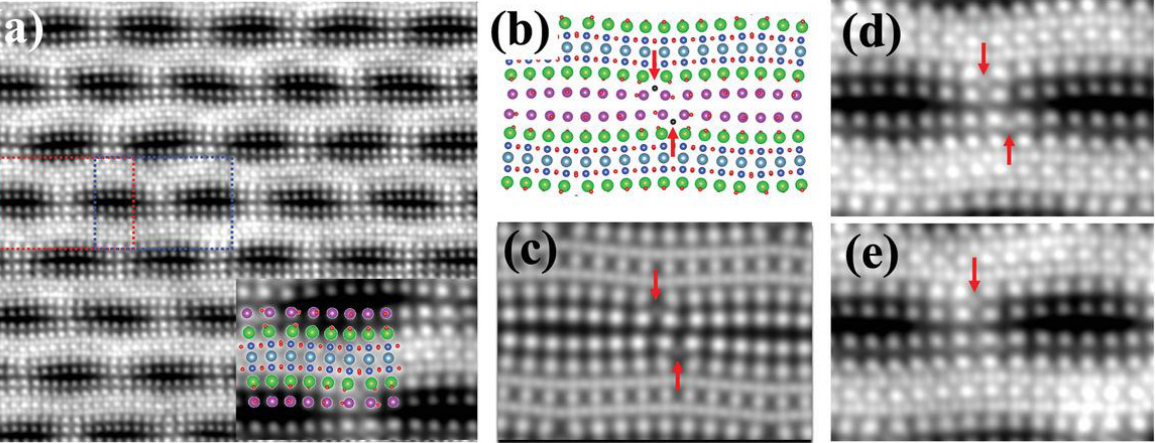
Figure 7. Imaging of dopant oxygen atoms. ( a ) iDPC − STEM image of Bi − 2212 along b − axis. ( b ) Schematic diagram of Bi − 2212. ( c ) Simulated iDPC − STEM image. Enlarged images taken from the dotted red ( d ) and blue ( e ) rectangles in ( a ). Reprinted with permission from Ref. [63]. Copyright 2019, Wiley.